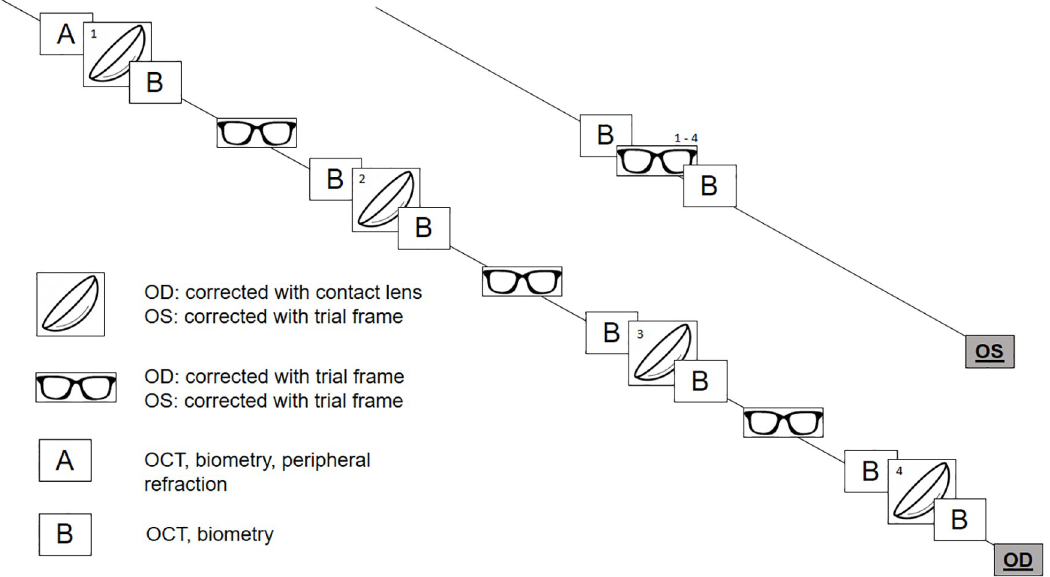
Fig 1. Study procedure of the main study. Subjects underwent OCT and biometry measurements before and after 30 min of contact lens wear. This was followed by a 15 min wash-out period with trial frame correction. The procedure was repeated for each of the four contact lenses. The left eye was constantly wearing trial frame correction while undergoing the same measurements at the same time points as the right eye.